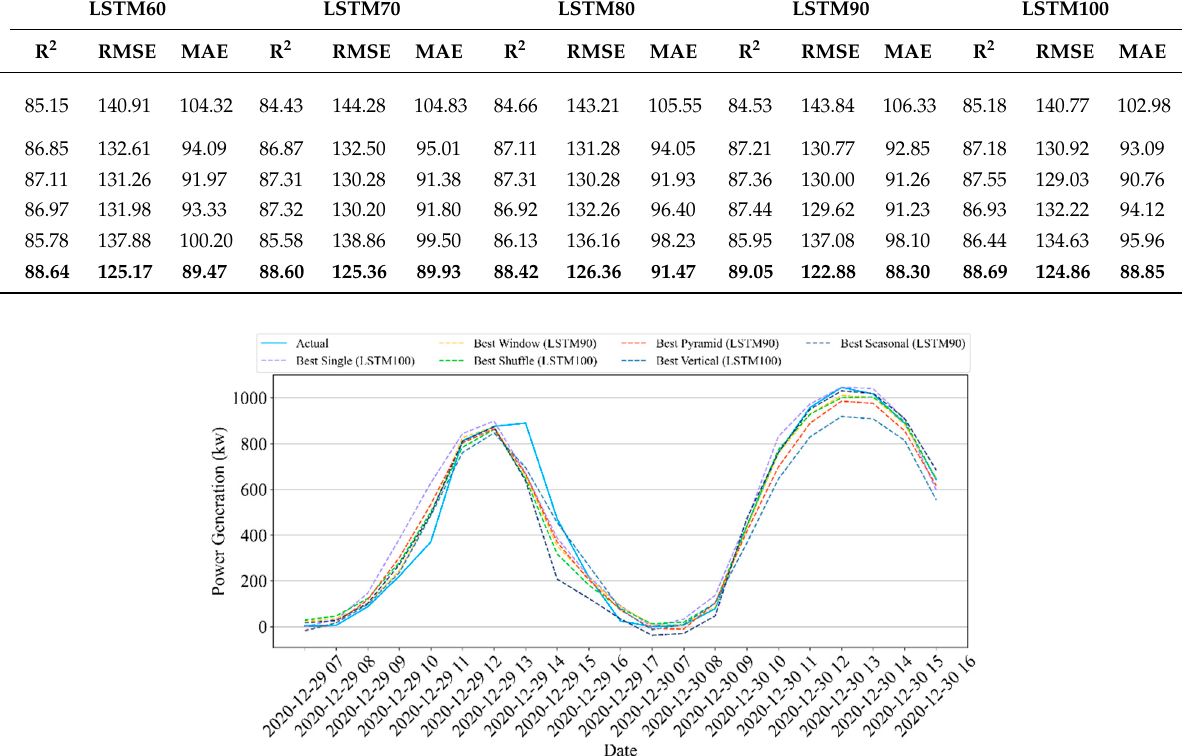
Table 8. Experimental results of hourly forecasting of Site B.